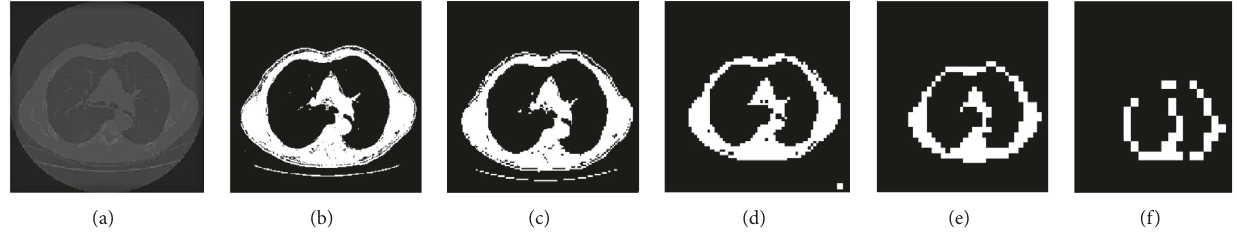
Figure 5: CT Scan image of a patient suffering from CLE and its different levels of 𝐿𝐿 images in wavelet transform (a) original image; (b) 1st